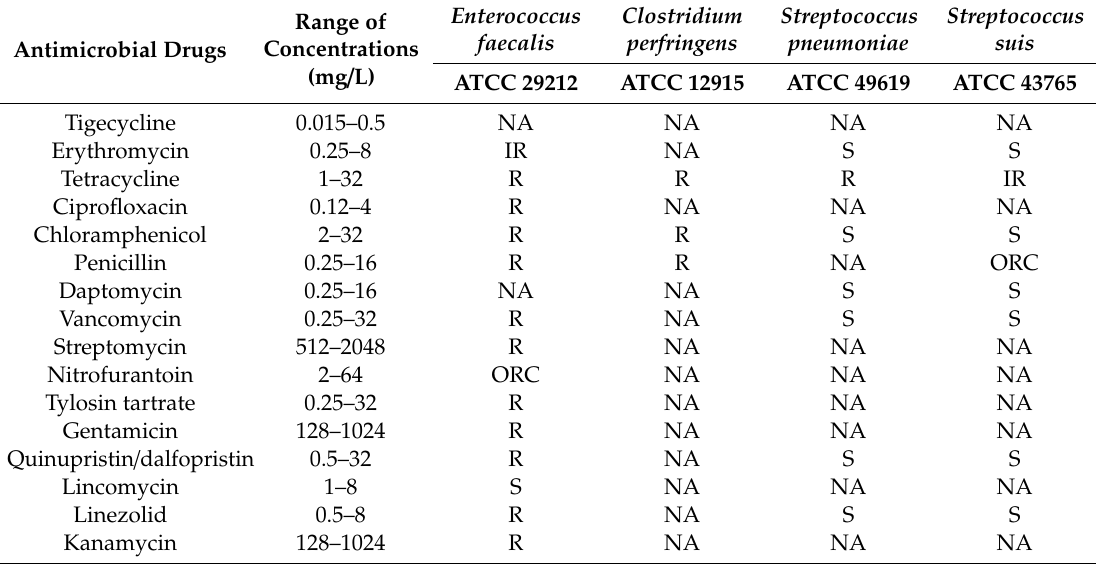
Table 5. Antimicrobial susceptibility of tested G + bacteria strains.